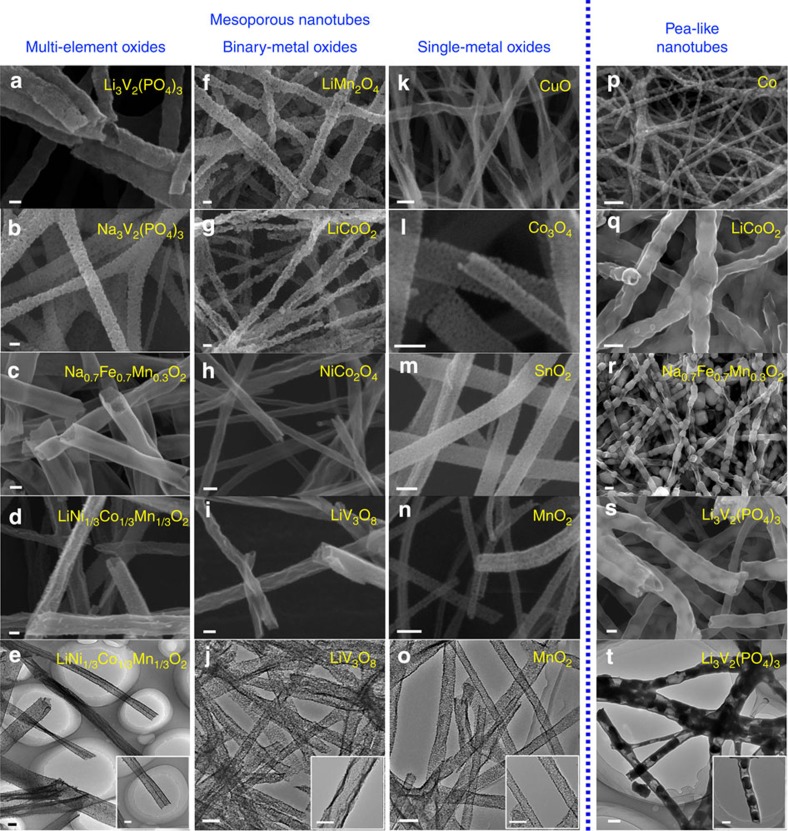
Expansion of the gradient electrospinning and controlled pyrolysis method.(a–o) SEM and TEM images of multi-element oxides (Li3V2(PO4)3, Na3V2(PO4)3, Na0.7Fe0.7Mn0.3O2 and LiNi1/3Co1/3Mn1/3O2), binary-metal oxides (LiMn2O4, LiCoO2, NiCo2O4 and LiV3O8) and single-metal oxides (CuO, Co3O4, SnO2 and MnO2) mesoporous nanotubes, respectively, scale bars, 100 nm. (p–t) SEM and TEM images of pea-like nanotubes (Co, LiCoO2, Li3V2(PO4)3 and Na0.7Fe0.7Mn0.3O2) from different species with scale bars at 200 nm. The scale bars for the inset TEM images (e, j, o, t) are 100 nm.